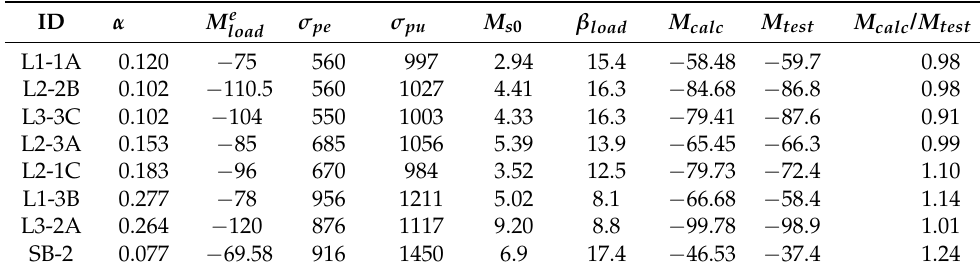
Table 6. Comparison between the calculation results and test results of the bending moment ampli- tude modulation formula (section of the middle